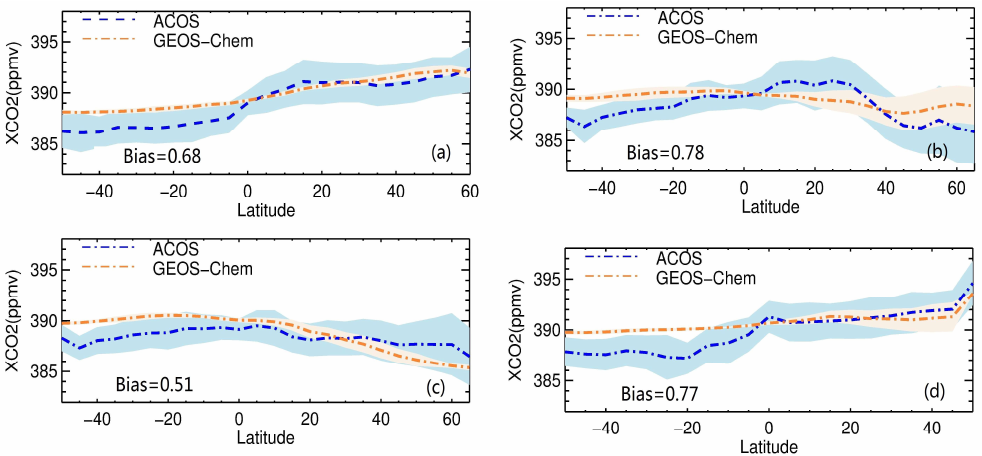
Figure 2. XCO 2 concentrations of GOSAT/ACOSv7.3 and GEOS-Chem averaged over 5° latitude bins during March 2010–February 2011: ( a ) MAM; ( b ) JJA; ( c ) SON; ( d ) DJF. Blue lines denote the latitudinal mean GOSAT/ACOSv7.3 XCO 2 data, with the light blue envelope representing their standard deviation. Orange line and light orange envelope denotes the latitudinal mean GEOS-Chem XCO 2 concentrations and their corresponding standard deviation.